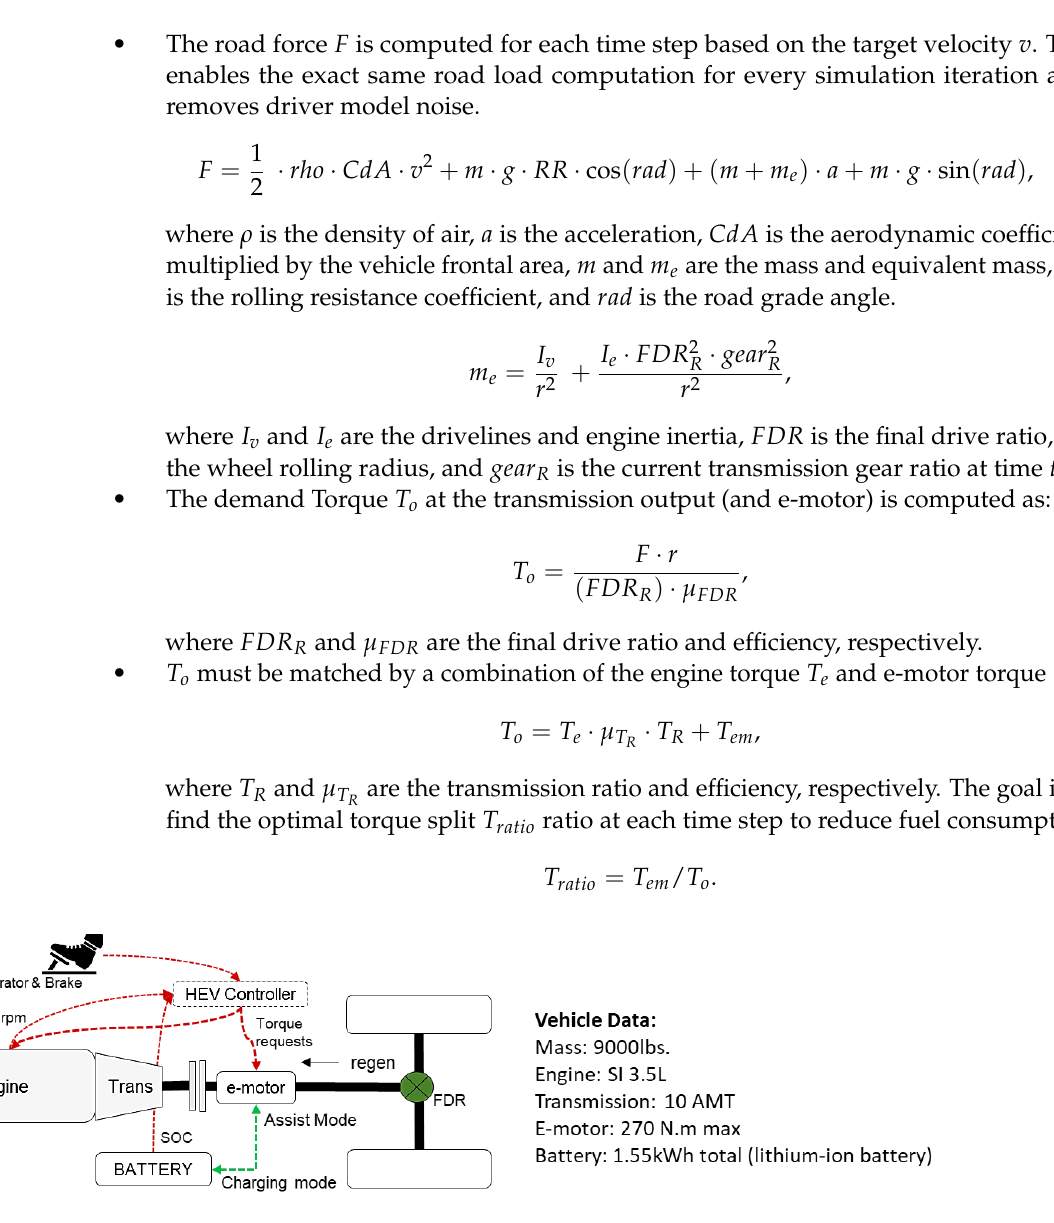
Figure 3. P3 HEV Powertrain architecture and conventional control